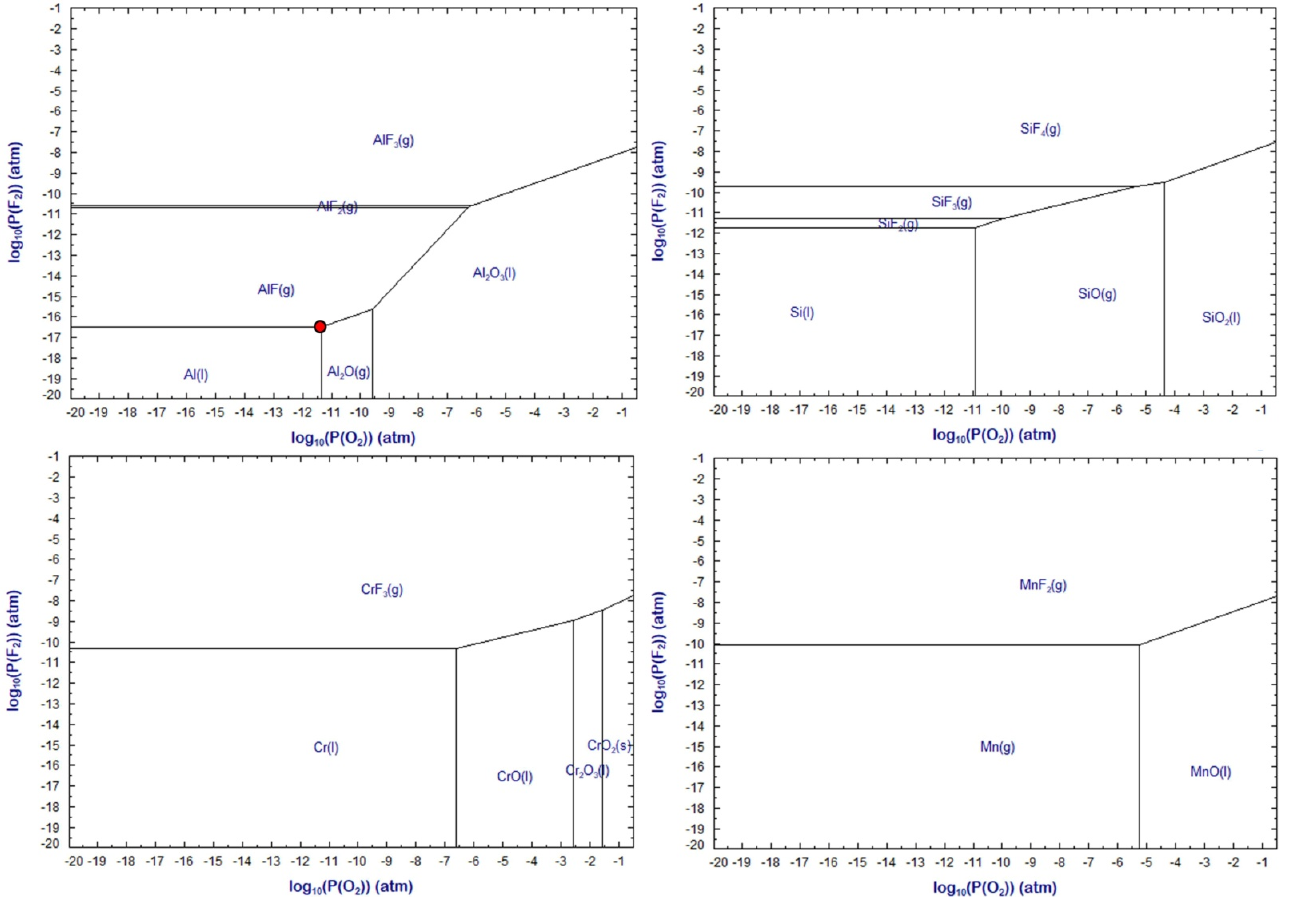
Figure 19. Predominance diagrams in M-O-F at 2500 °C (M = Al, Cr, Fe, Mn, Si).